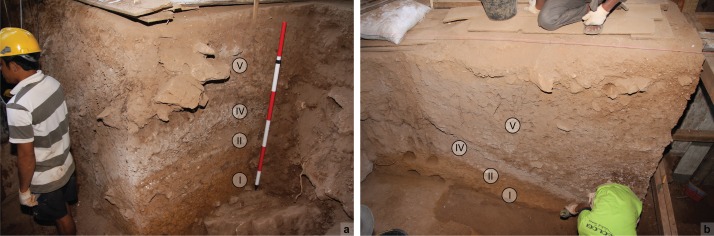
Stratigraphy revealed by Glover’s 1975 trench at Leang Burung 2.As viewed after emptying backfill in 2012; (a) north wall of square H9 and east wall of square G8; (b) south wall of Glover’s 1975 trench, squares E10 to G10.